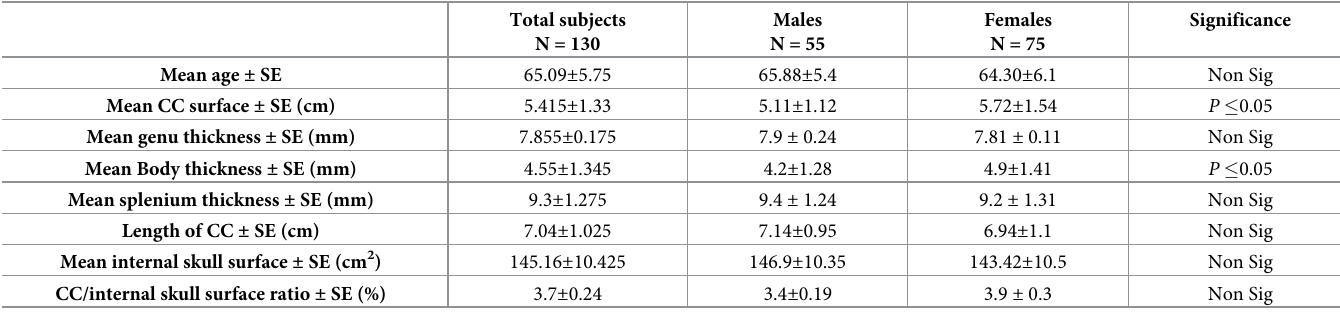
Table 3. Average CC values in Alzheimer disease patients.